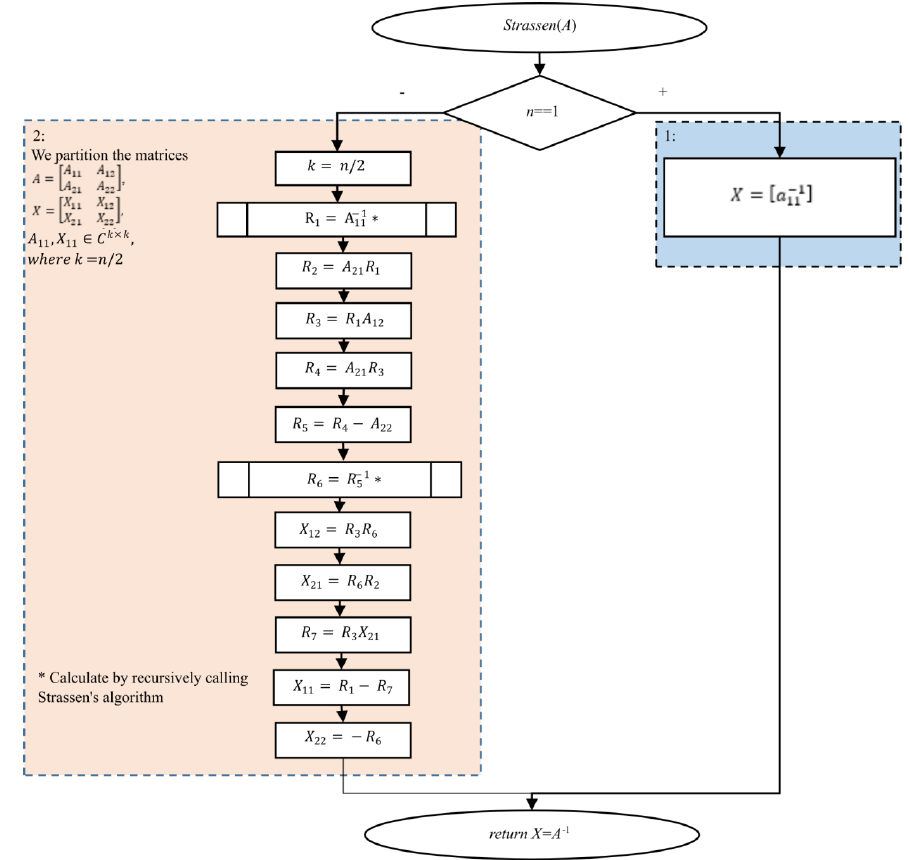
Figure 2. Algorithm 4.2 (Figure A2) : Strassen’s matrix inverse algorithm. Recursion calls are marked with “*”